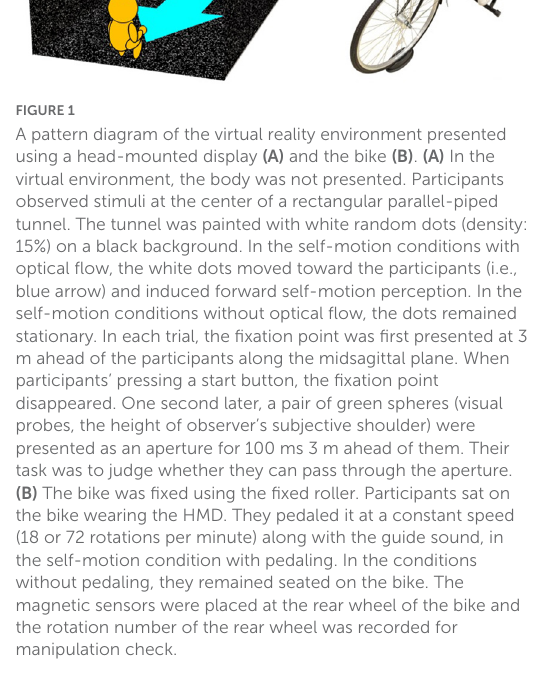
A bike ( Figure 1B ; wheel size: 27 inches, handle type: